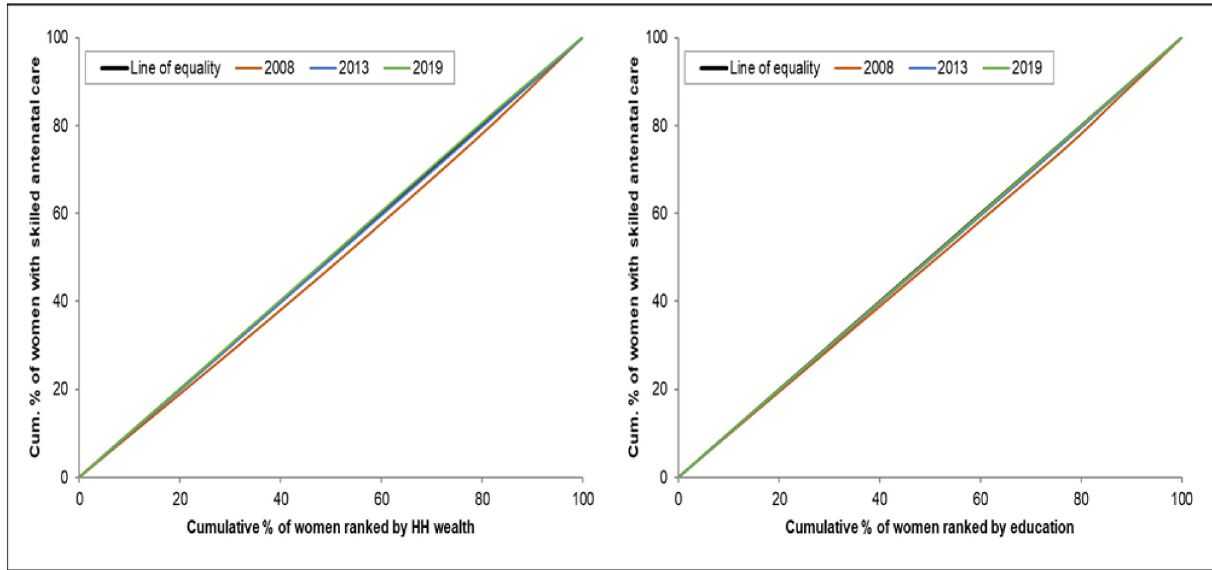
Fig 2. Concentration curves showing wealth-and-education-based inequality in the use of skilled antenatal services in Sierra Leone, 2008, 2013 and 2019.